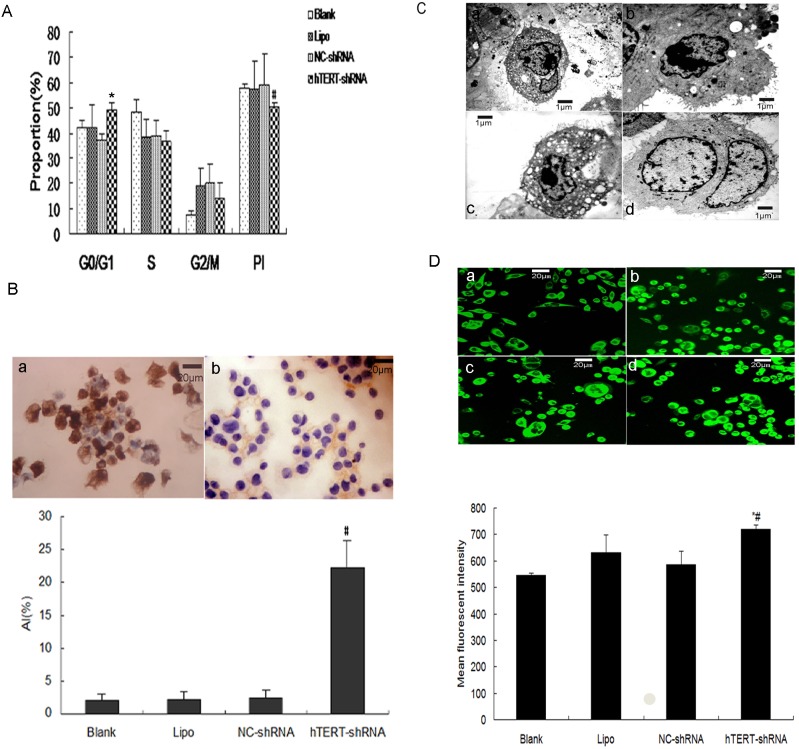
hTERT down-regulation reduces SW480 growth and proliferation and increases apoptosis at 48 h in vitro.(A) hTERT-shRNA reduces growth and proliferation of SW480 cells. The proportion of cells in G0/G1 phase was significantly higher and the proliferation index was much lower after transfection with hTERT-shRNA than after control transfections. *P<0.05, compared with the other three groups; #
P<0.05, compared with NC-shRNA. (B) hTERT-shRNA increases apoptosis of SW480 cells. Cells were transfected with (a) hTERT-shRNA or (b) NC-shRNA, stained with diaminobenzidine (brown) and counter-stained with hematoxylin (blue) to label nuclei. Images are representative results from three independent experiments. Magnification, ×400. The apoptotic index (AI) was significantly higher in cells transfected with hTERT-shRNA. #
P<0.01, compared with the other three groups. (C) Transmission electron microscopy analysis of SW480 cells transfected with (a-c) hTERT-shRNA or (d) NC-shRNA. Apoptotic morphology was visible in cells transfected with hTERT-shRNA. Magnification, ×3800. (D) Rhodamine 123 fluorescence intensity analysis of SW480 cells transfected with (a) culture medium alone (Blank), (b) Lipofectamine alone (Lipo), (c) NC-shRNA or (d) hTERT-shRNA. Stained cells were analyzed by confocal scanning microscopy; higher fluorescence intensity indicates lower mitochondrial membrane potential. Magnification, ×400. Cells transfected with hTERT-shRNA showed significantly higher rhodamine 123 fluorescence than did control cells. *P<0.05, compared with NC-shRNA or Lipo; #
P<0.01, compared with Blank. Results are the mean ± SD from three independent experiments.